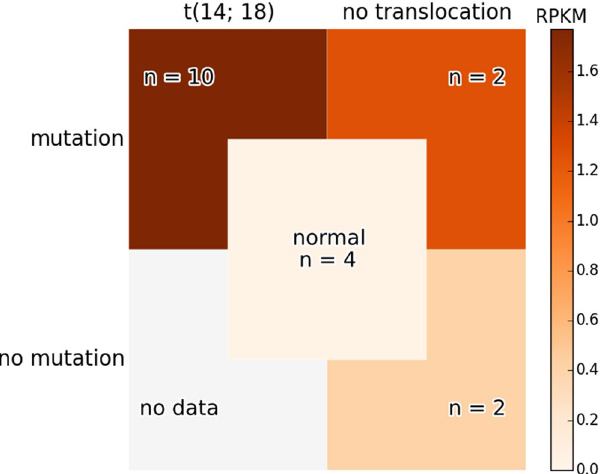
Figure 6. BCL2 expression dependency on mutations. The heat-map shows median BCL2 expression level (RPKM) for groups carrying combinations of BCL2 regulatory block SNVs and t(14; 18) translocation. The median expression level of the four normal GCB samples is shown in the middle for